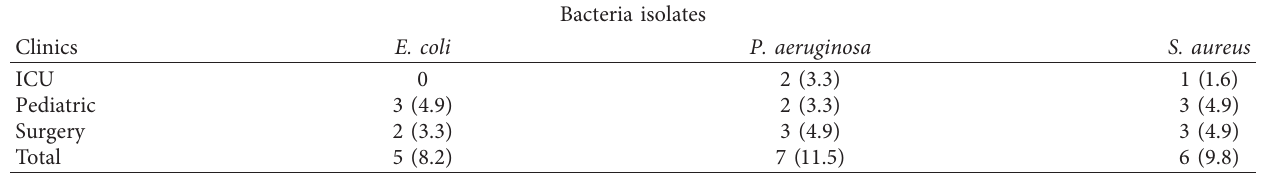
Table 3: Bacteriological identification by wards with plates settling biocontamination.